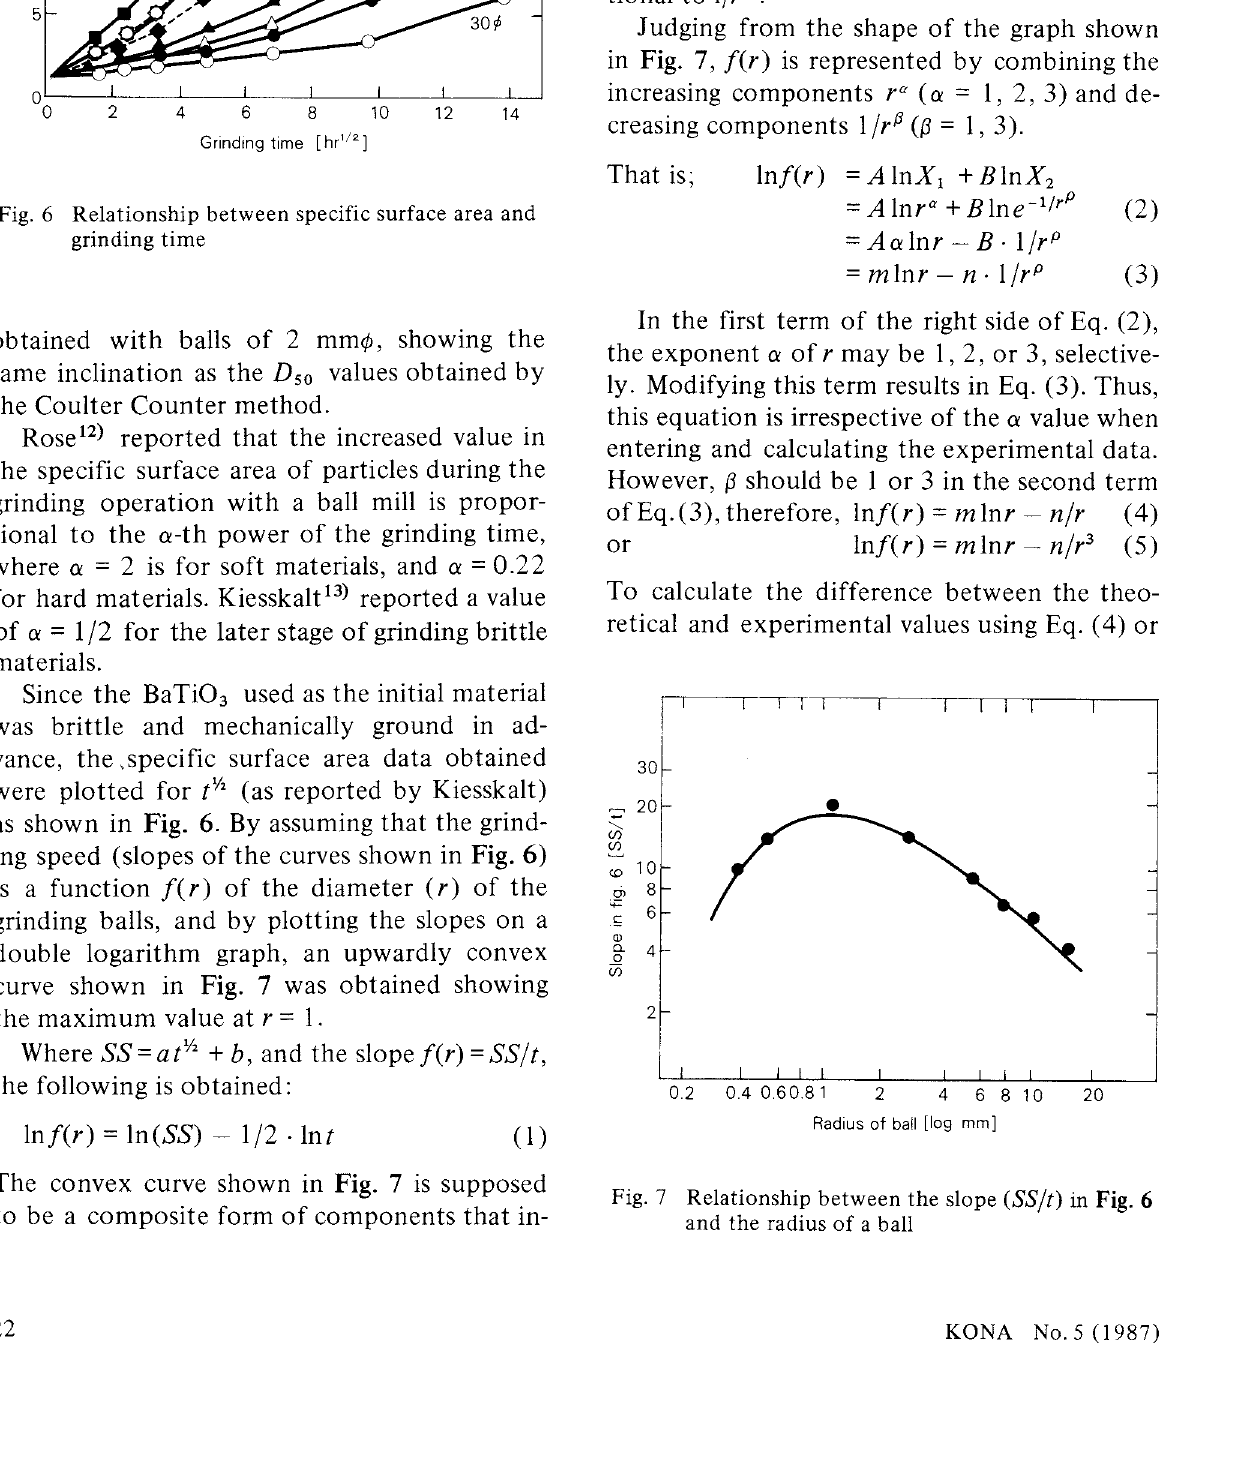
Fig. 7 Relationship between the slope (SS/t) in Fig. 6 and the radius of a ball